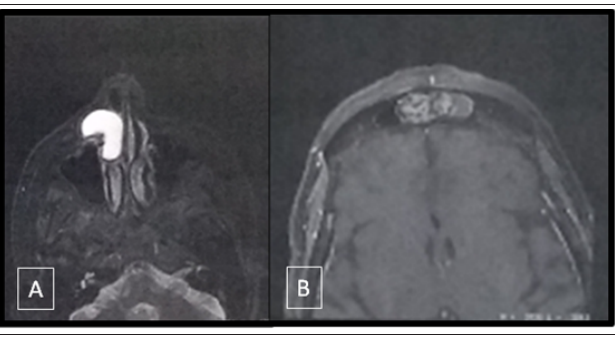
Imagem em corte axial evidenciando a lesão maxilar (A) e do seio frontal (B).